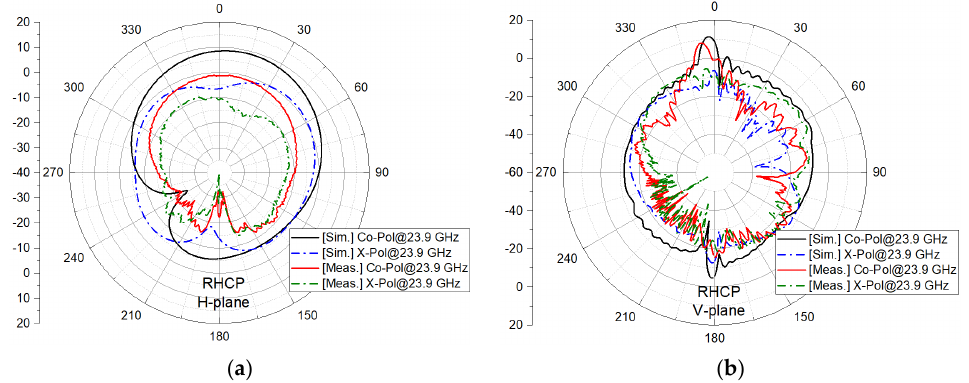
Figure 11. ( a ) S−parameters of the circular polarizer and ( b ) reflection coefficient of the HMSIW RHCP slot array antenna.